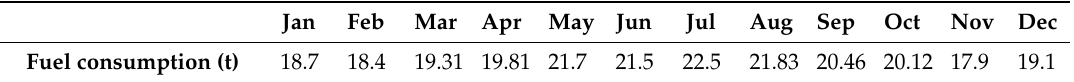
Table 12. Monthly fuel consumption of Zhongshan